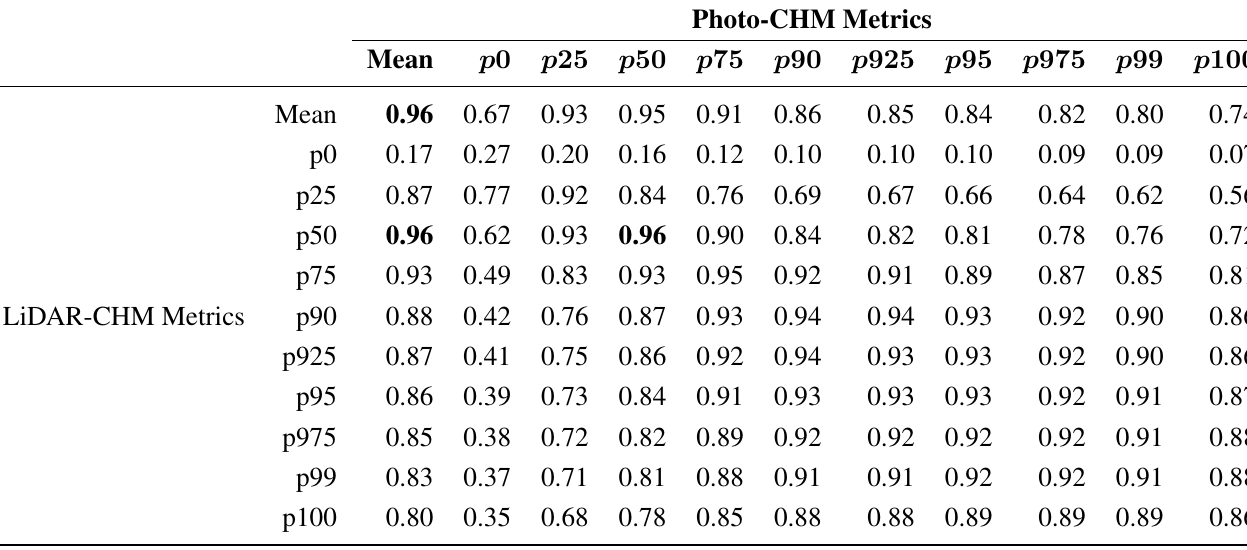
Table 2. Correlation between photo-CHM and LiDAR-CHM window metrics. Bold figures represent the highest correlation